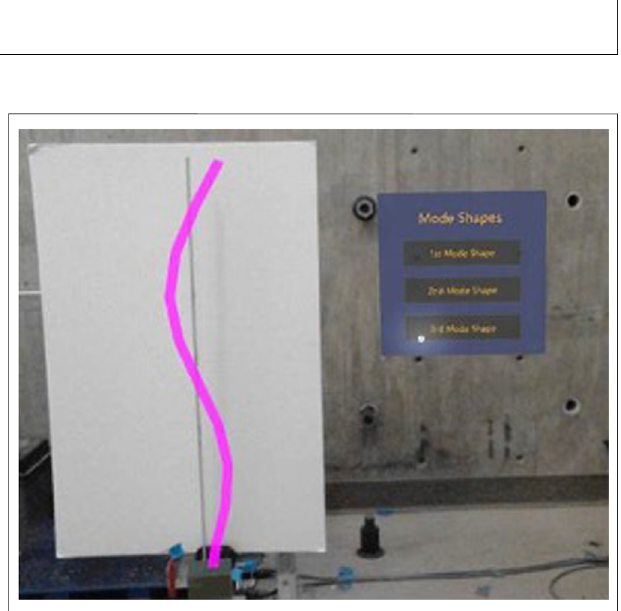
FIGURE 9 | Displaying virtual model shape onto the shaking table experiments. Hossain et al.